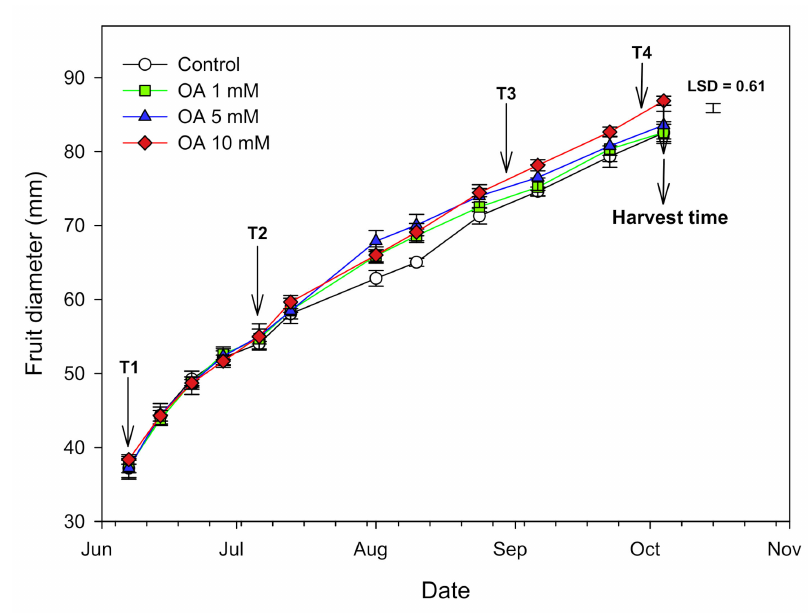
Figure 1. Pomegranate fruit diameter (mm) during on-tree fruit development as a ff ected by oxalic acid (OA) treatment at 1, 5, and 10 mM in the 2016 experiment. Data are the mean ± SE. LSD 0.05 bar among treatments is shown. Arrows indicate the di ff erent key moments of treatments (T1, T2, T3, and T4) and the harvest